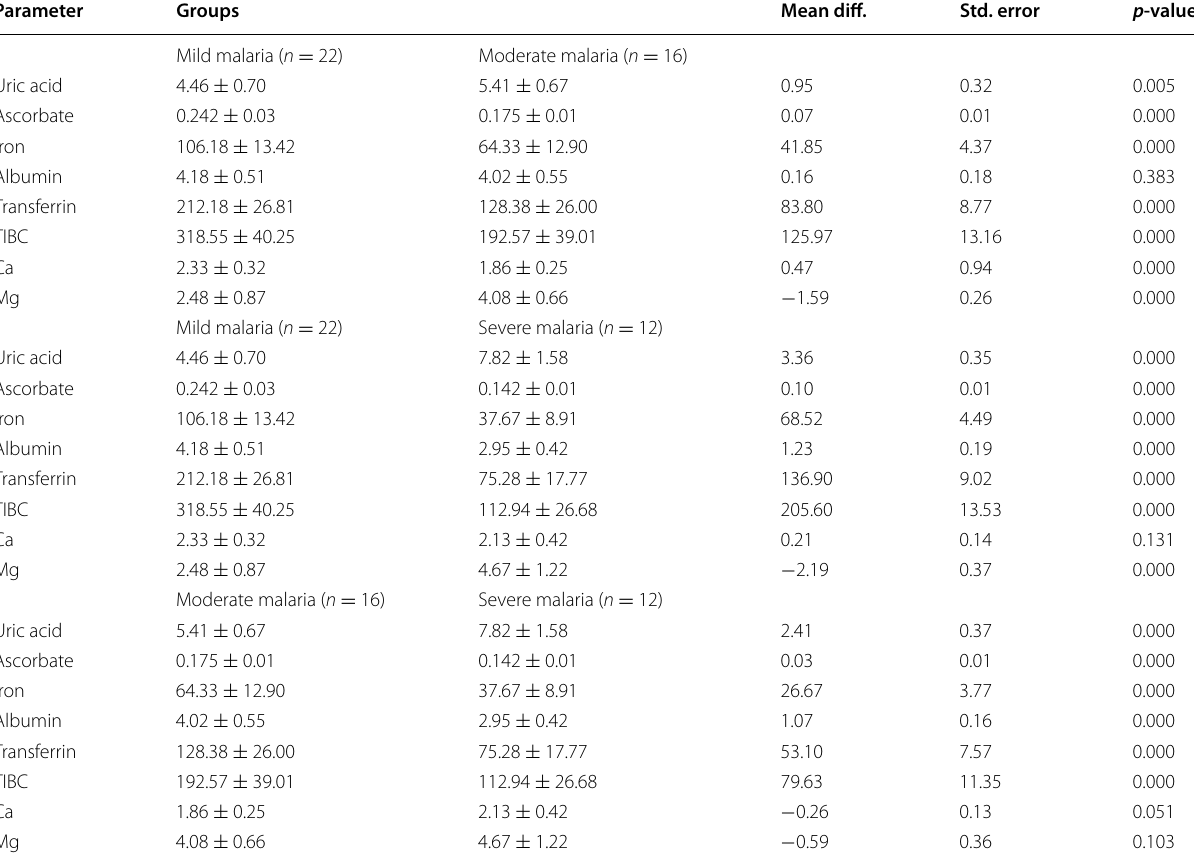
Table 3 Uric acid, ascorbic acid, iron, albumin, transferrin, TIBC, Ca, and Mg levels in children with mild, moderate, and severe malaria using LSD post hoc